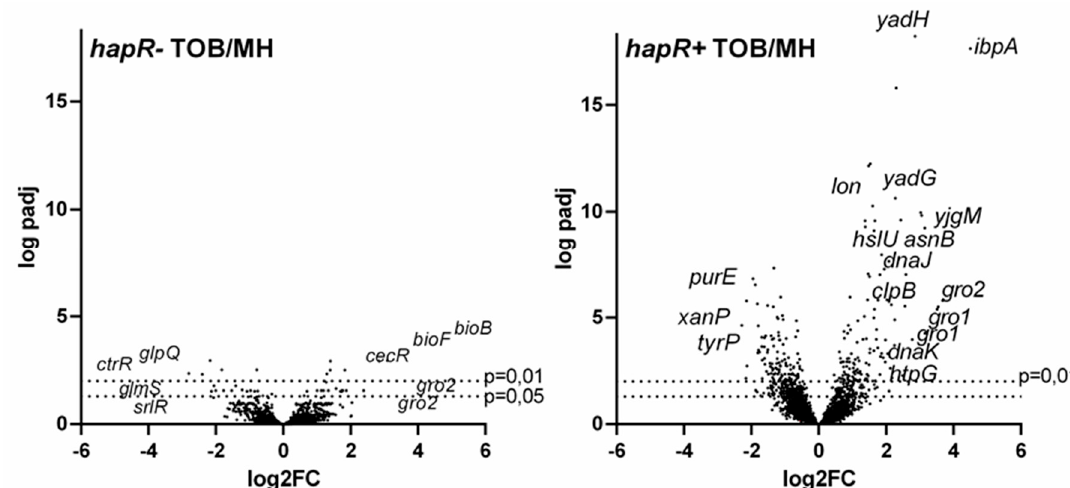
Figure 2. Transcriptomic profiles of V. cholerae cells treated with subMIC TOB depend on HapR proficiency. Volcano plots depicting gene expression changes caused by subMIC TOB (2% MIC) in HapR deficient ( left panel ) or HapR proficient ( right panel ) V. cholerae cells. The names of the genes with the strongest fold changes are represented. The x-axis represents the log 2 of the fold change plotted against the log 10 of the adjusted p -value.